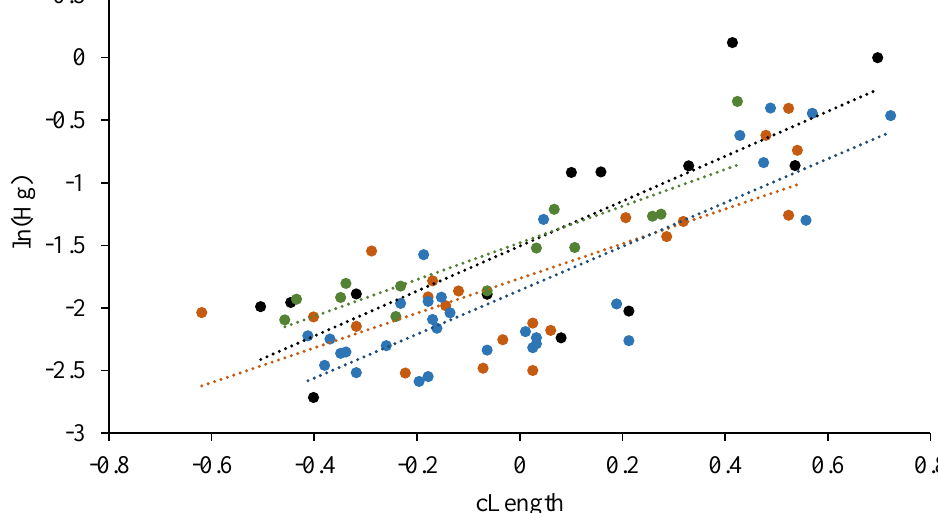
Figure 9. Linear regressions for A. charr, using centered, transformed length as an explanatory variable and logarithmically transformed Tot-Hg-concentration as a response. Seasons are coloured as green (spring), orange (summer), blue (autumn) and black (winter).